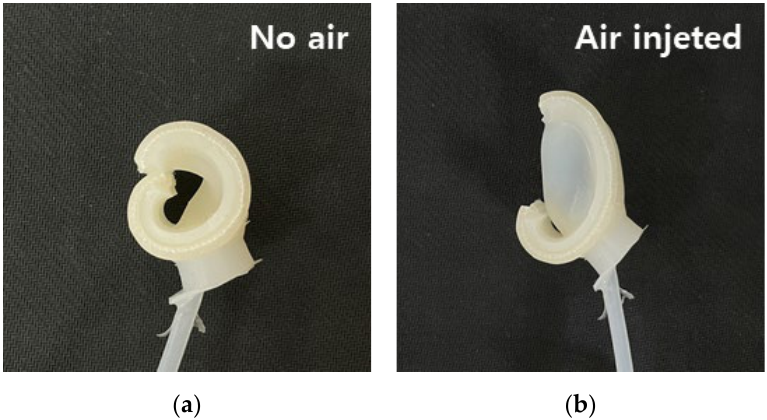
Figure 7. Movement of soft mechanisms by air injection. ( a ) State when air is not injected into the soft mechanism; ( b ) state when air is injected into the soft mechanism.